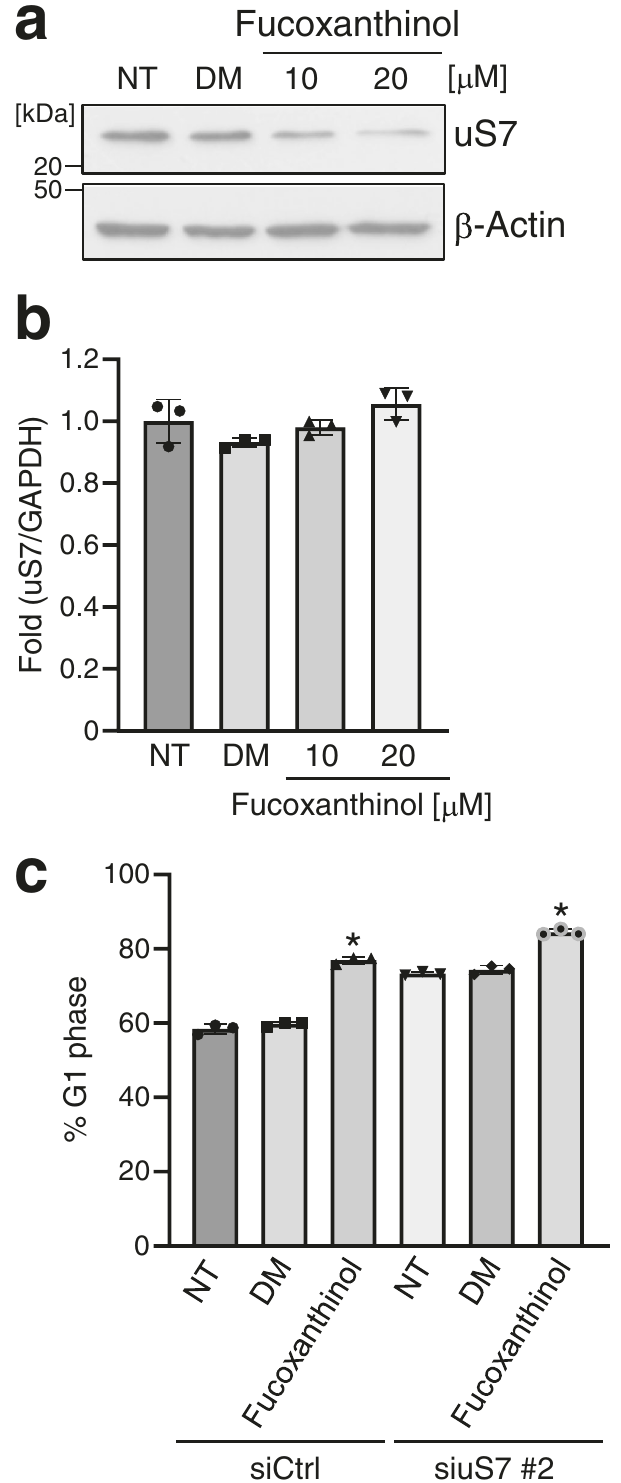
Fig. 6 Fucoxanthinol decreases the uS7 protein, resulting in G1 cell cycle arrest. HT-29 cells were treated with the indicated concentrations of fucoxanthinol for 6 h, and the protein ( a ) and mRNA ( b ) levels of uS7 were examined by western blotting and qRT-PCR analyses. c HT-29 cells were transfected with siCtrl or siuS7 #2. After 48 h, cells were incubated with 10 μ M fucoxanthinol for 24 h, and the cell cycle was analyzed by fl ow cytometry. NT: non-treated, DM: 0.1% DMSO, Data are means ± S.D. ( n = 3 biologically independent experiments). * P < 0.05 signi fi cantly different from